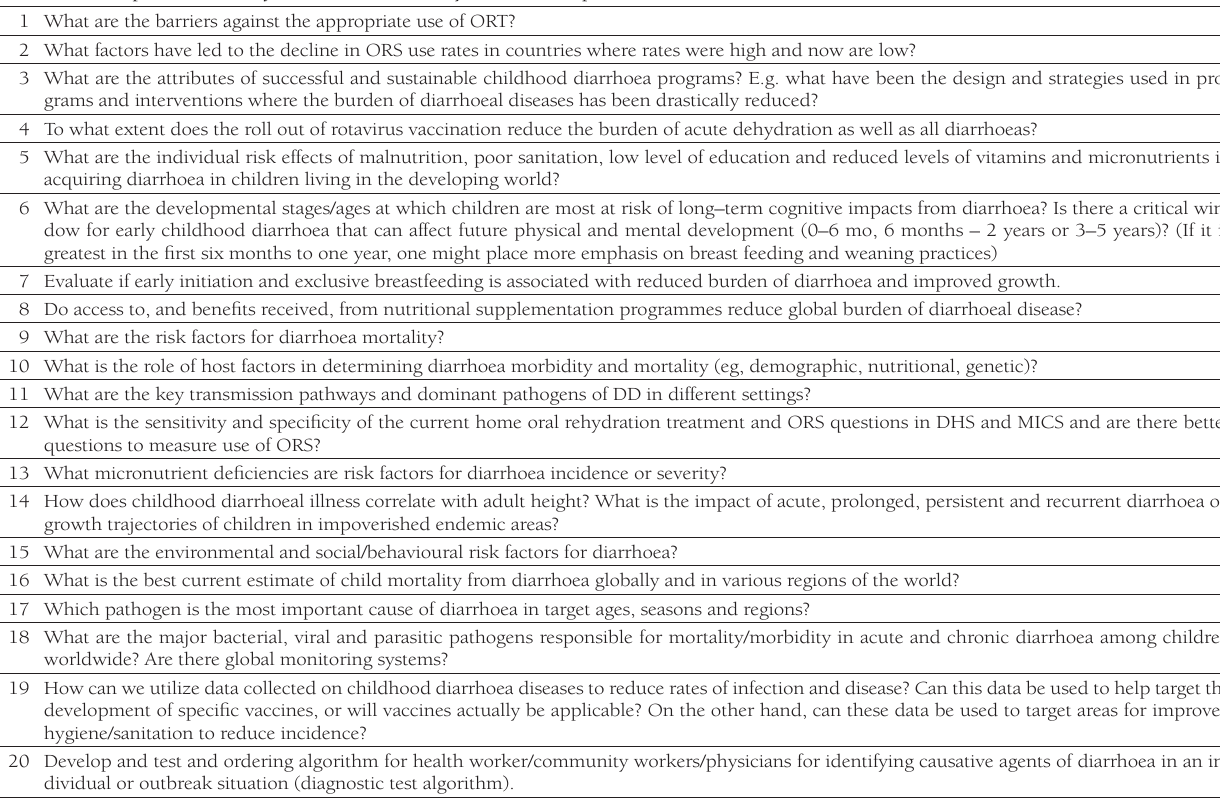
Table 2. Description related questions identified by the CHNRI